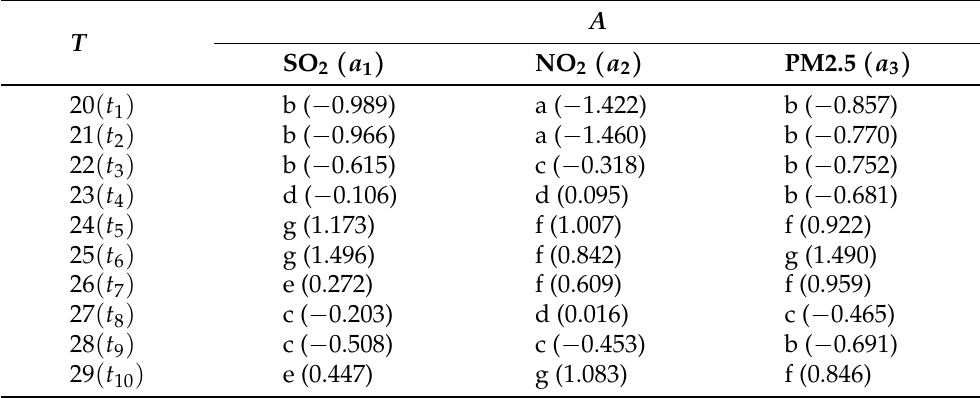
Table 3. An example of SAX-MTS and